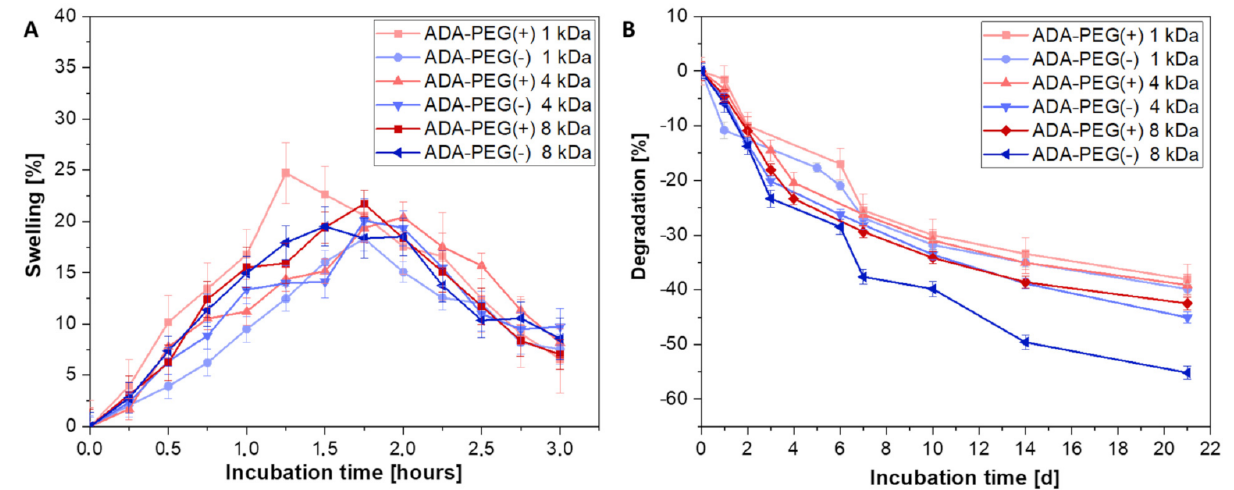
Figure 4. ( A ) Swelling and ( B ) degradation behaviour of ADA-PEG inks incubated in HBSS at 37 ◦ C for 21 days ( n =